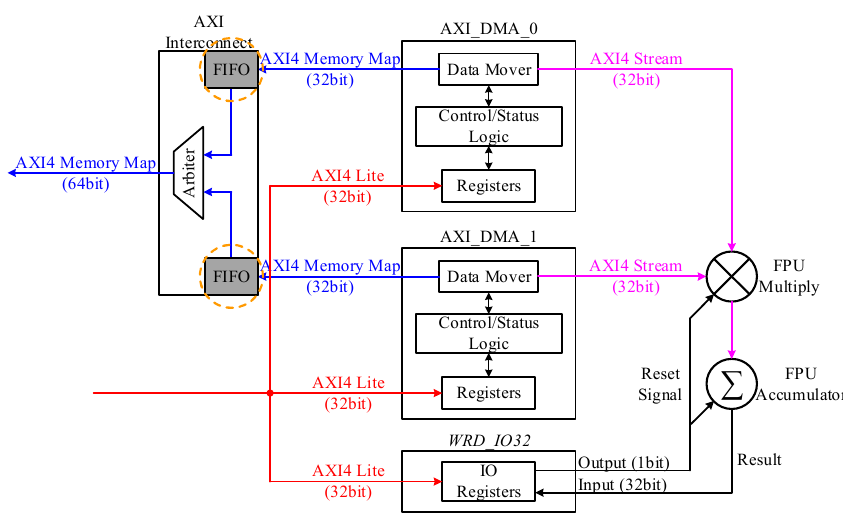
Figure 7. Processing element (PE) architecture with optimization.